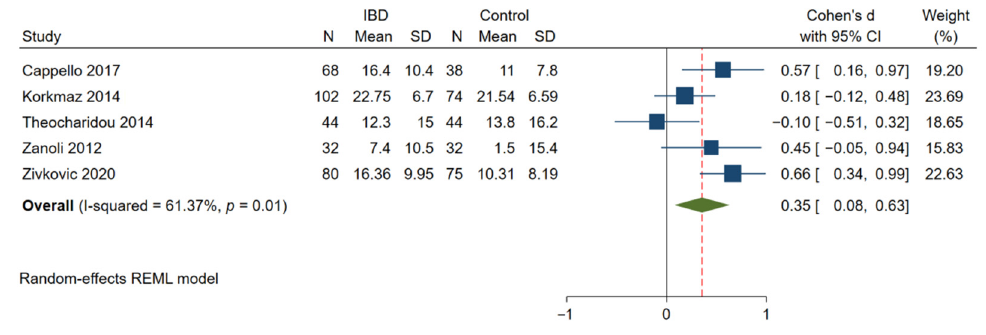
Figure 4. Meta-analysis of studies reporting on AIx in patients with IBD compared to matched controls. AIx, augmentation index.